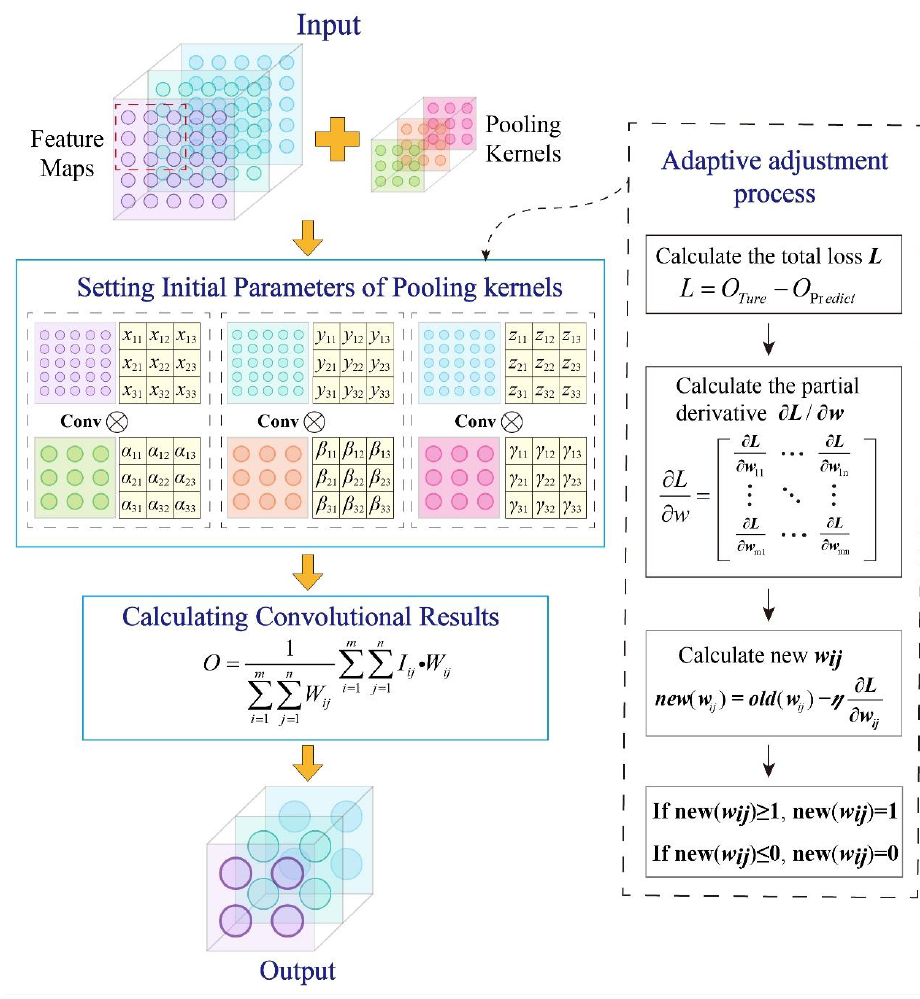
Figure 7. Process of the adaptive pooling